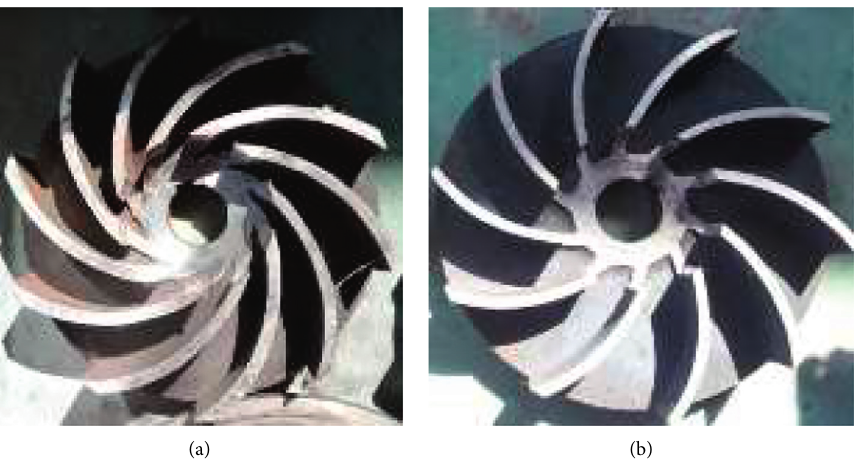
Figure 4: The pump impeller in the original model and optimization model: (a) prototype impeller; (b) optimization impeller.